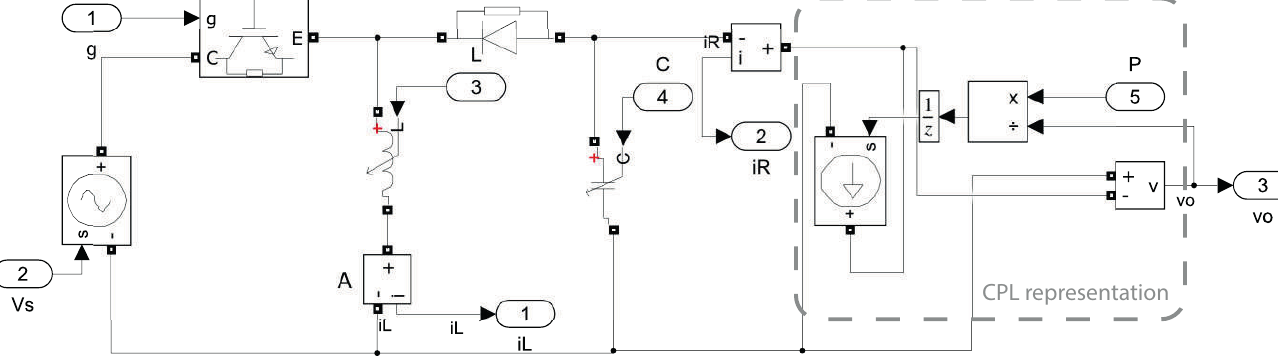
( c ) This figure represent the inside of the sub-system, but for the CPL case, which is shown at the right side. Their values are given by an arbitrary external signal. Figure A1. The implementation on simulink is presented here: ( a ) Representation of buck-boost converter system build in a classic simulink environment block; ( b ) Buck-Boost electrical scheme build by a specialized block with R ( t ) load; ( c ) Buck-Boost electrical scheme build by a